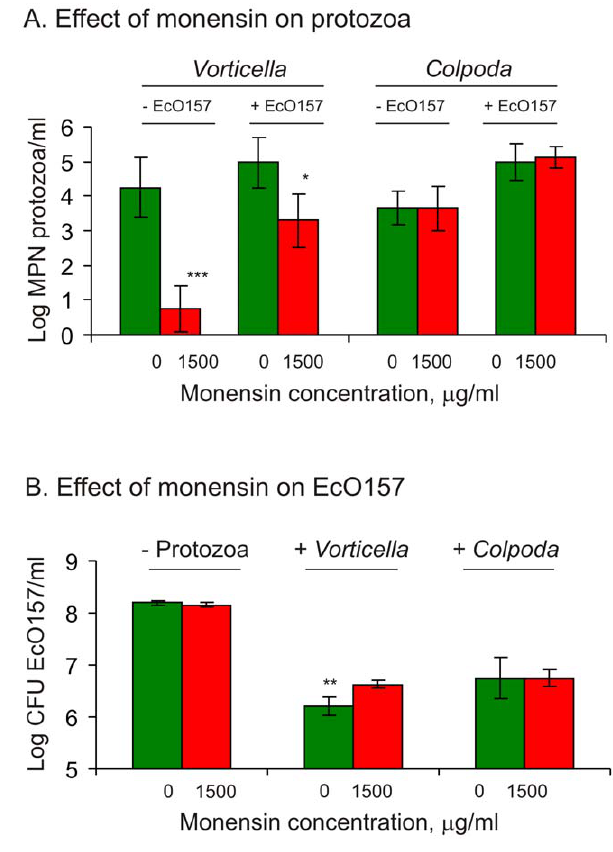
Figure 5. Effect of monensin on the growth of EcO157 and protozoa isolated from dairy wastewater. Changes in protozoan numbers (A) in response to supplementation of monensin or EcO157 and changes in EcO157 populations (B) in the presence or absence of protozoa or monensin were monitored after a 6-day incubation in PBS supplemented with 10% Sonneborn medium. Values are averages of triplicates. Bonferroni post tests: * = P , 0.05; ** = P , 0.01; and ***= P ,